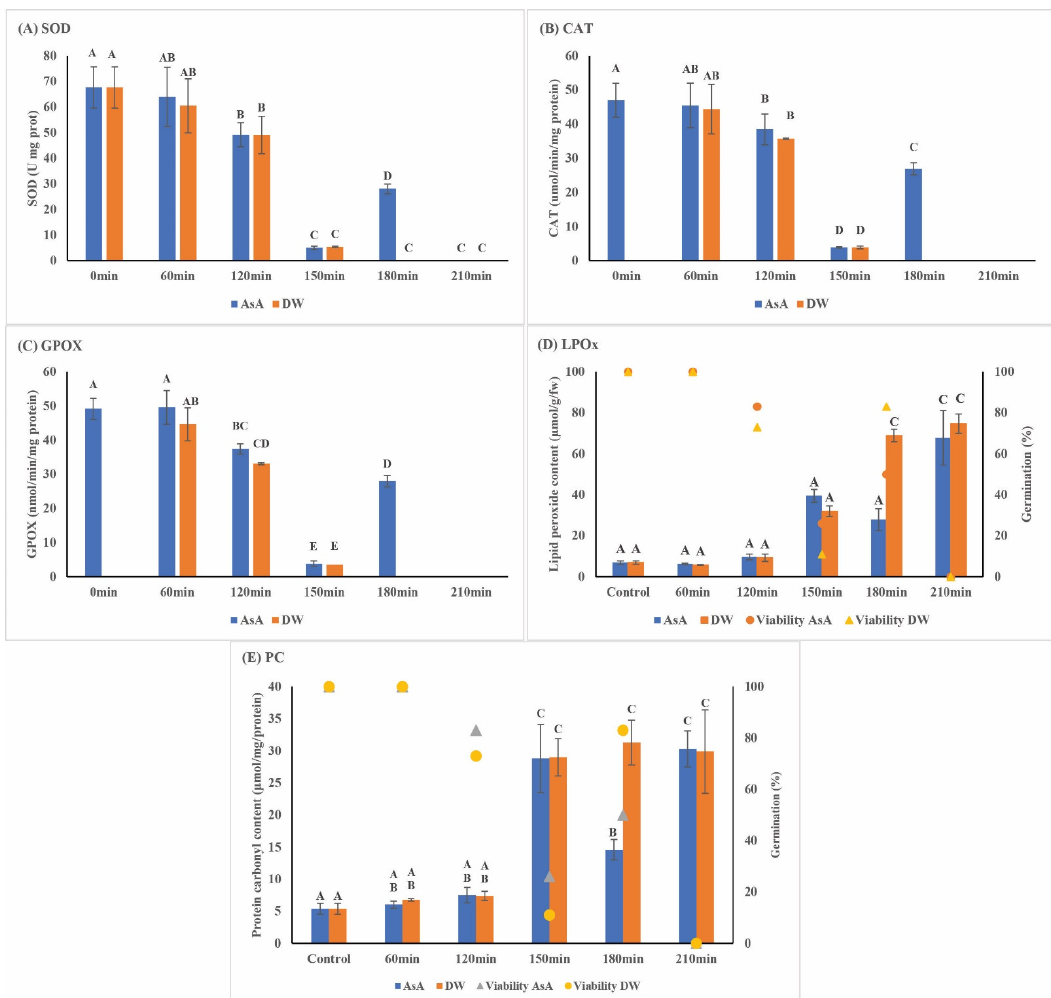
Figure 3. Superoxide dismutase (SOD) ( A ), catalase (CAT) ( B ) and glutathione peroxidase GPOX ( C ) activities in the embryonic axis (EA) of Syzygium maire at various desiccation treatments following rehydration in ascorbic acid (AsA) or distilled water (DW) for 30 min. The impact of desiccation on lipid peroxide content (LPOx) ( D ) and protein carbonyl (PC) content ( E ) of Syzygium maire EA. Symbols represent mean viability for each treatment, error bars represent SD of the mean. The letters above the bars indicate a significant difference based on Tukey’s HSD ( p < 0.05).